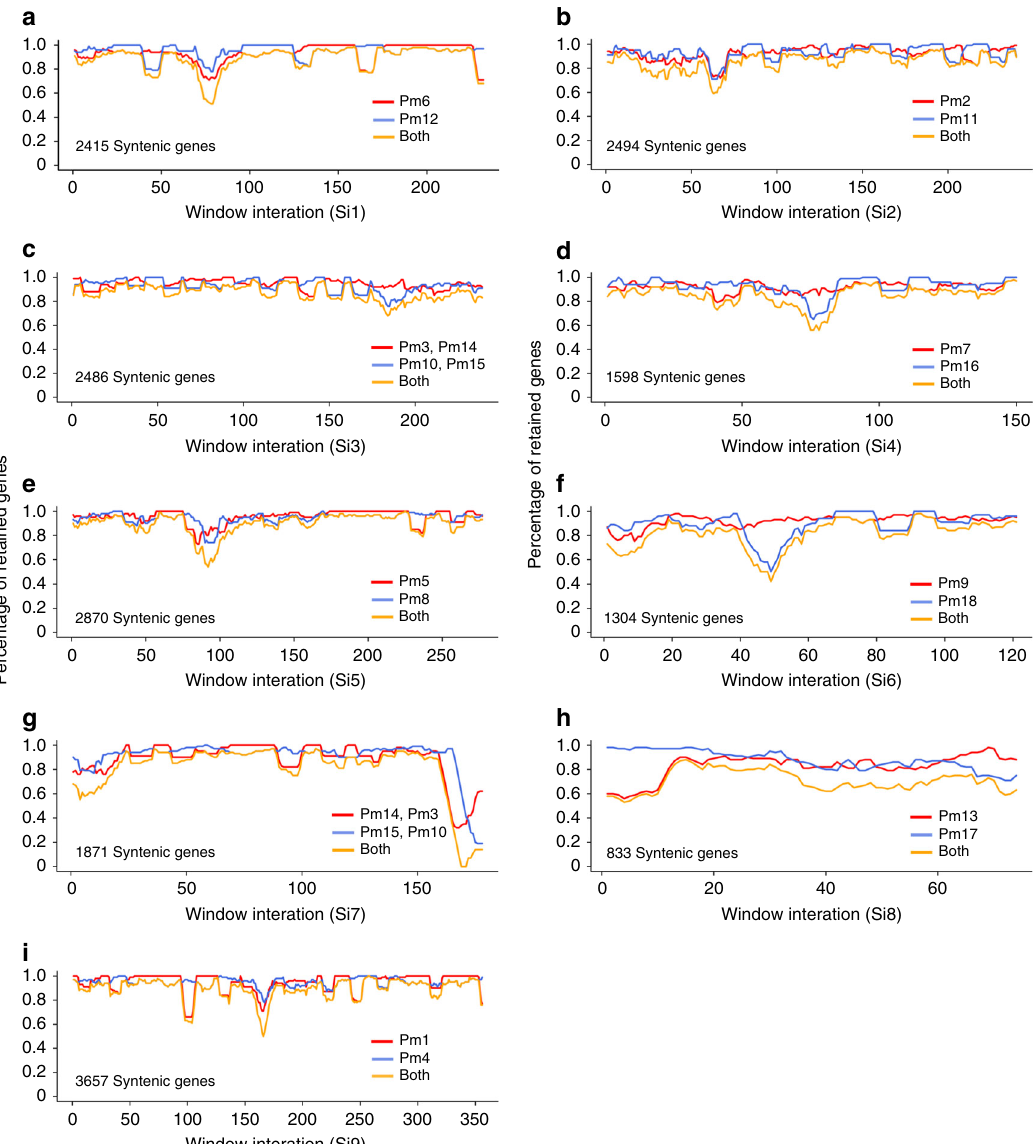
Fig. 2 Gene loss and retentions in broomcorn millet. a sliding window approach with window size of 100 syntenic genes and step size of 10 syntenic genes was used to show the percentage of retained genes in subgenome1 (red), subgenome2 (blue), and both (yellow) in broomcorn millet using foxtail millet (a~i) as a reference. In total, there were 19,609 genes in foxtail millet that were syntenic with at least one subgenome in broomcorn millet, among which 16,884 (~86.2%) syntenic genes have two homologous copies retained in broomcorn millet. Source Data are provided as a Source Data fi